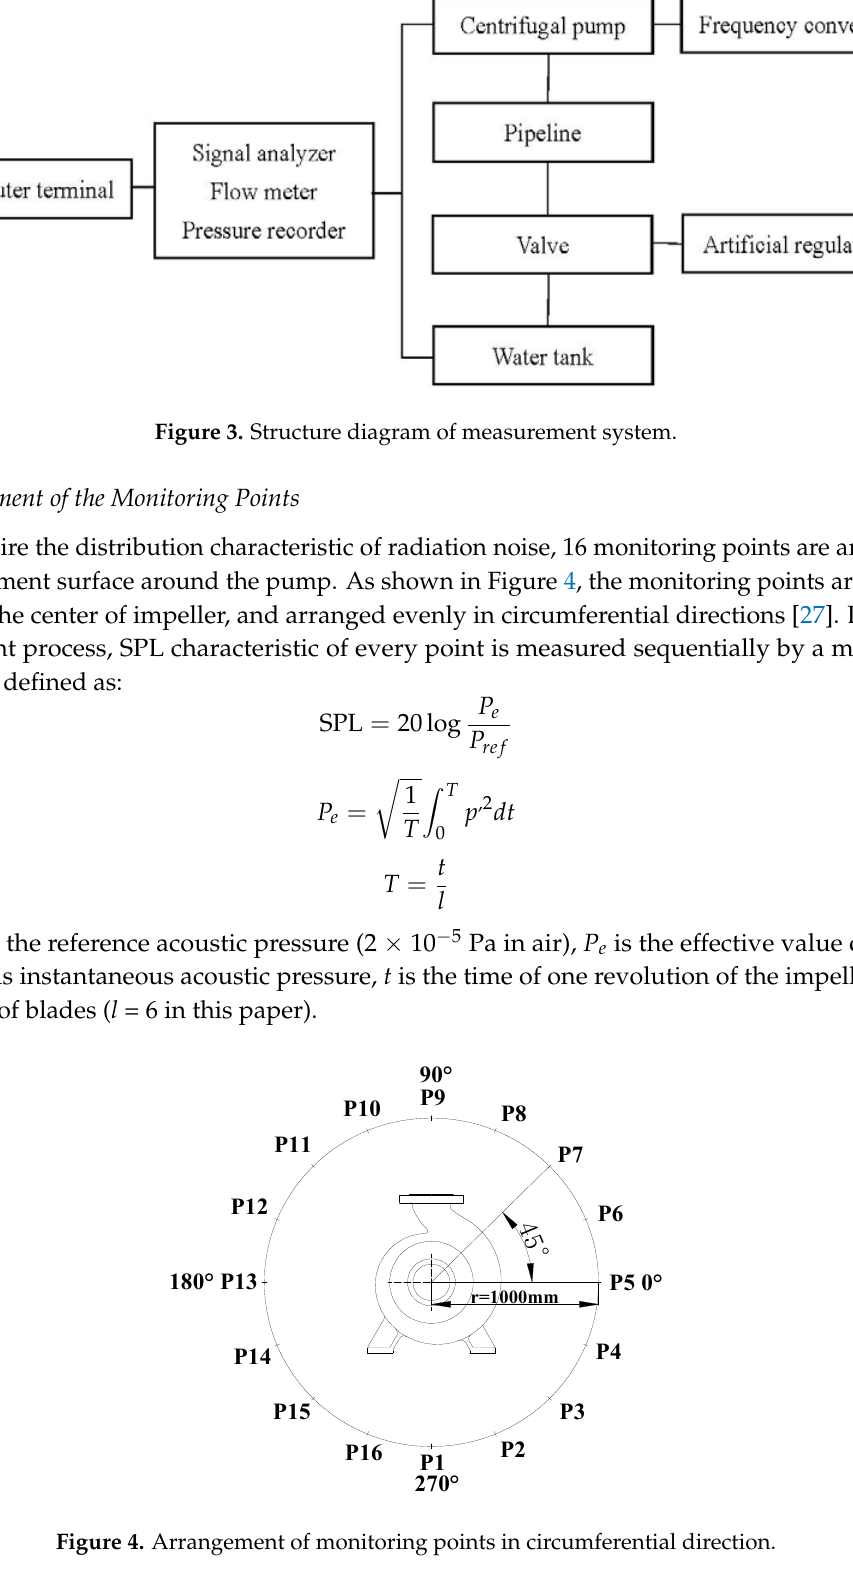
Figure 4. Arrangement of monitoring points in circumferential direction.